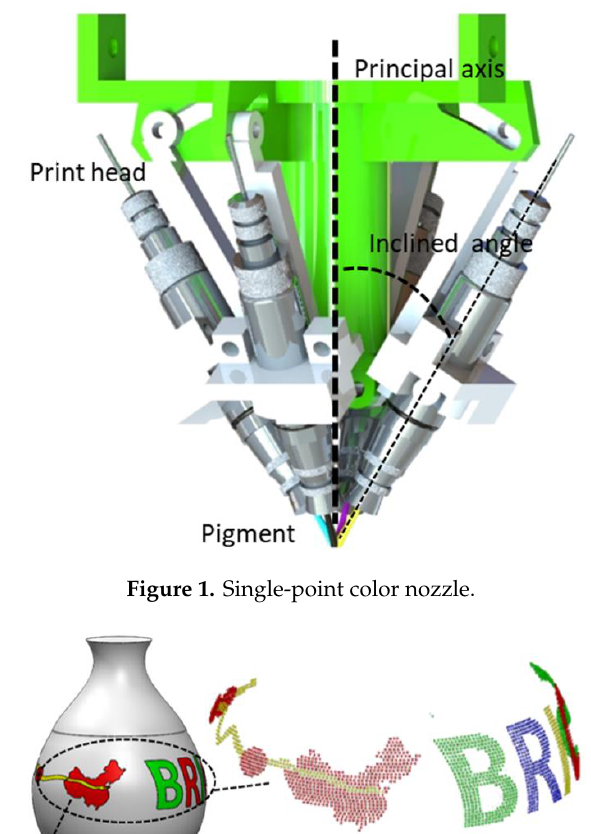
Figure 2. Surface patterns are formed by a series of printing points.